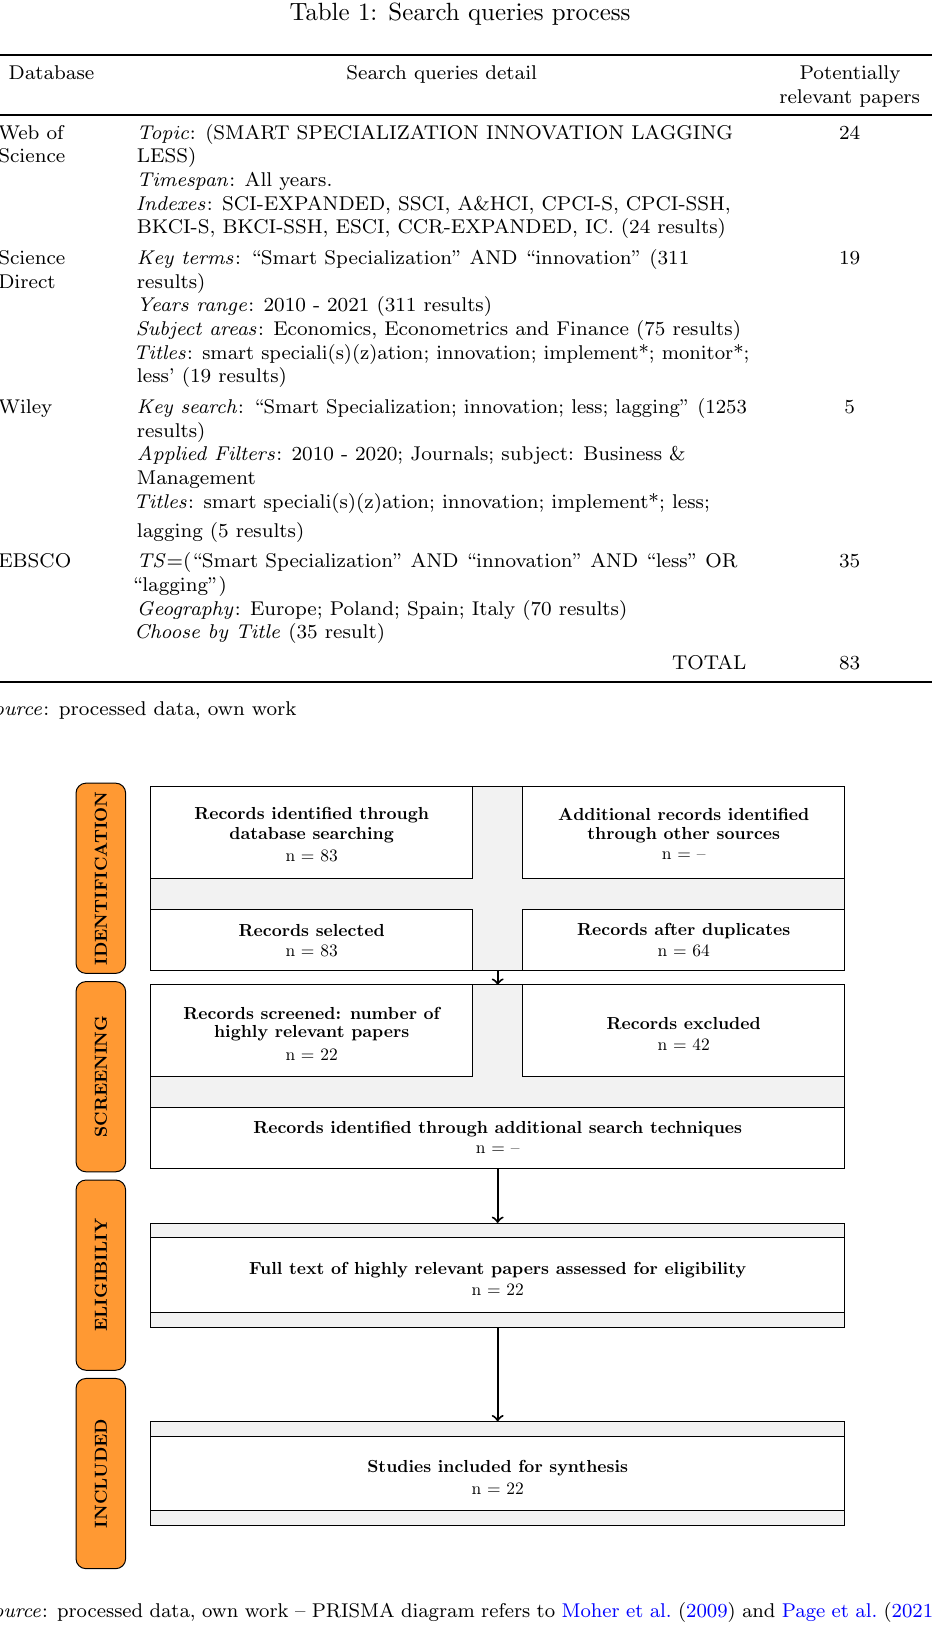
Figure 1: PRISMA diagram of the paper search